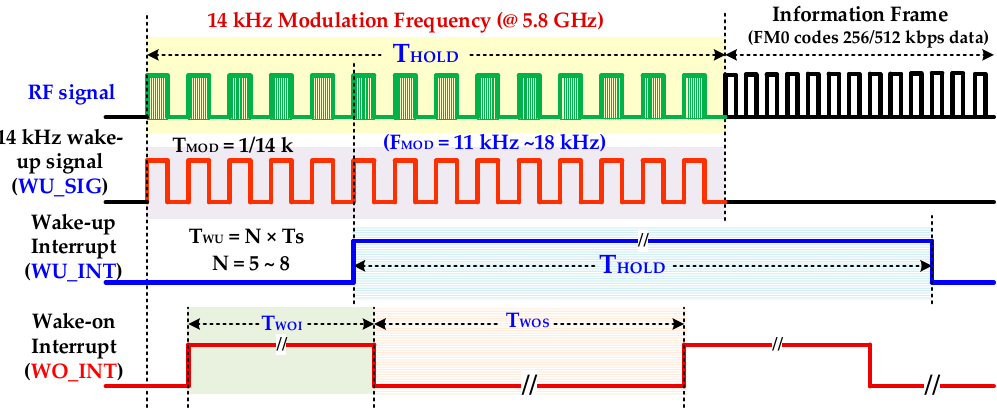
Figure 6. RF WuRx intelligent digital controller (IDC) architecture.